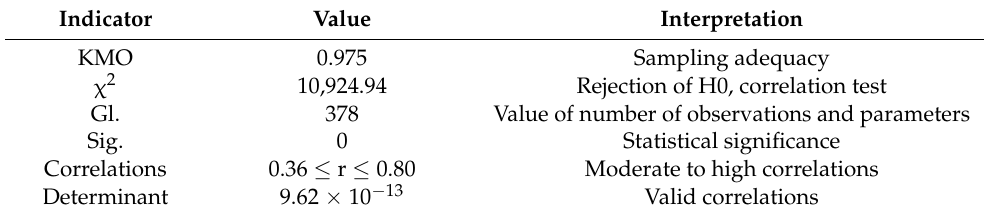
Table 8. Preliminary factorial results of the ethical values in teamwork.